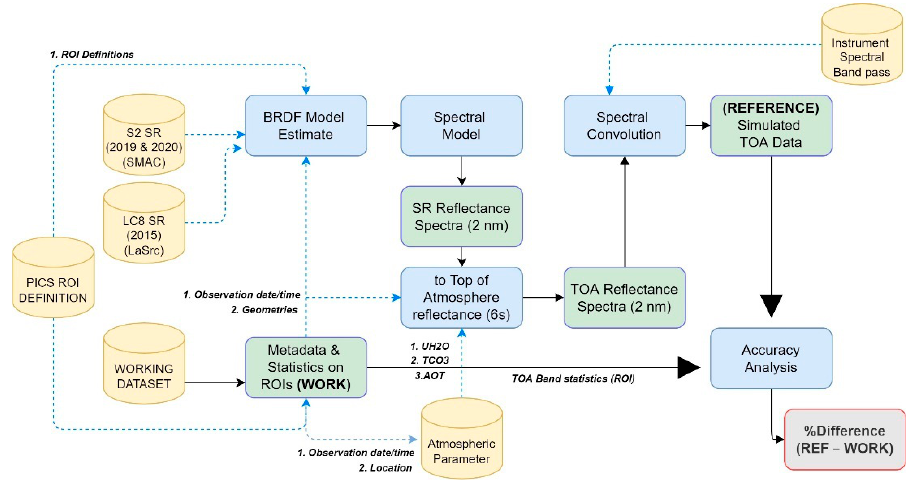
Figure 6. The workflow of absolute radiometric calibration using PICS data.